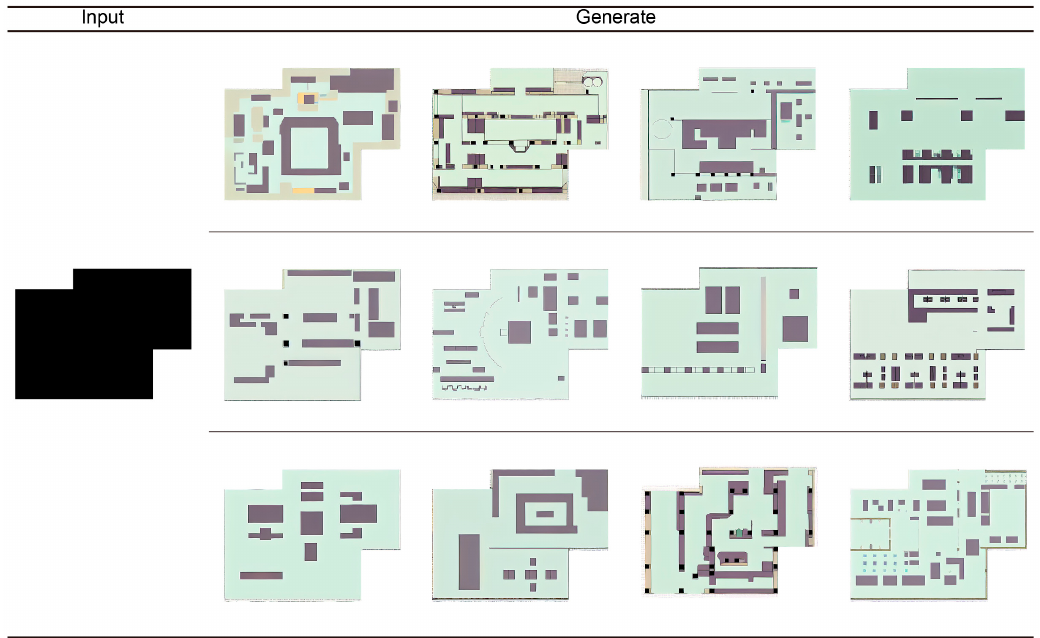
Figure 10. Changing the noise label (Z) of the input model can generate multiple different